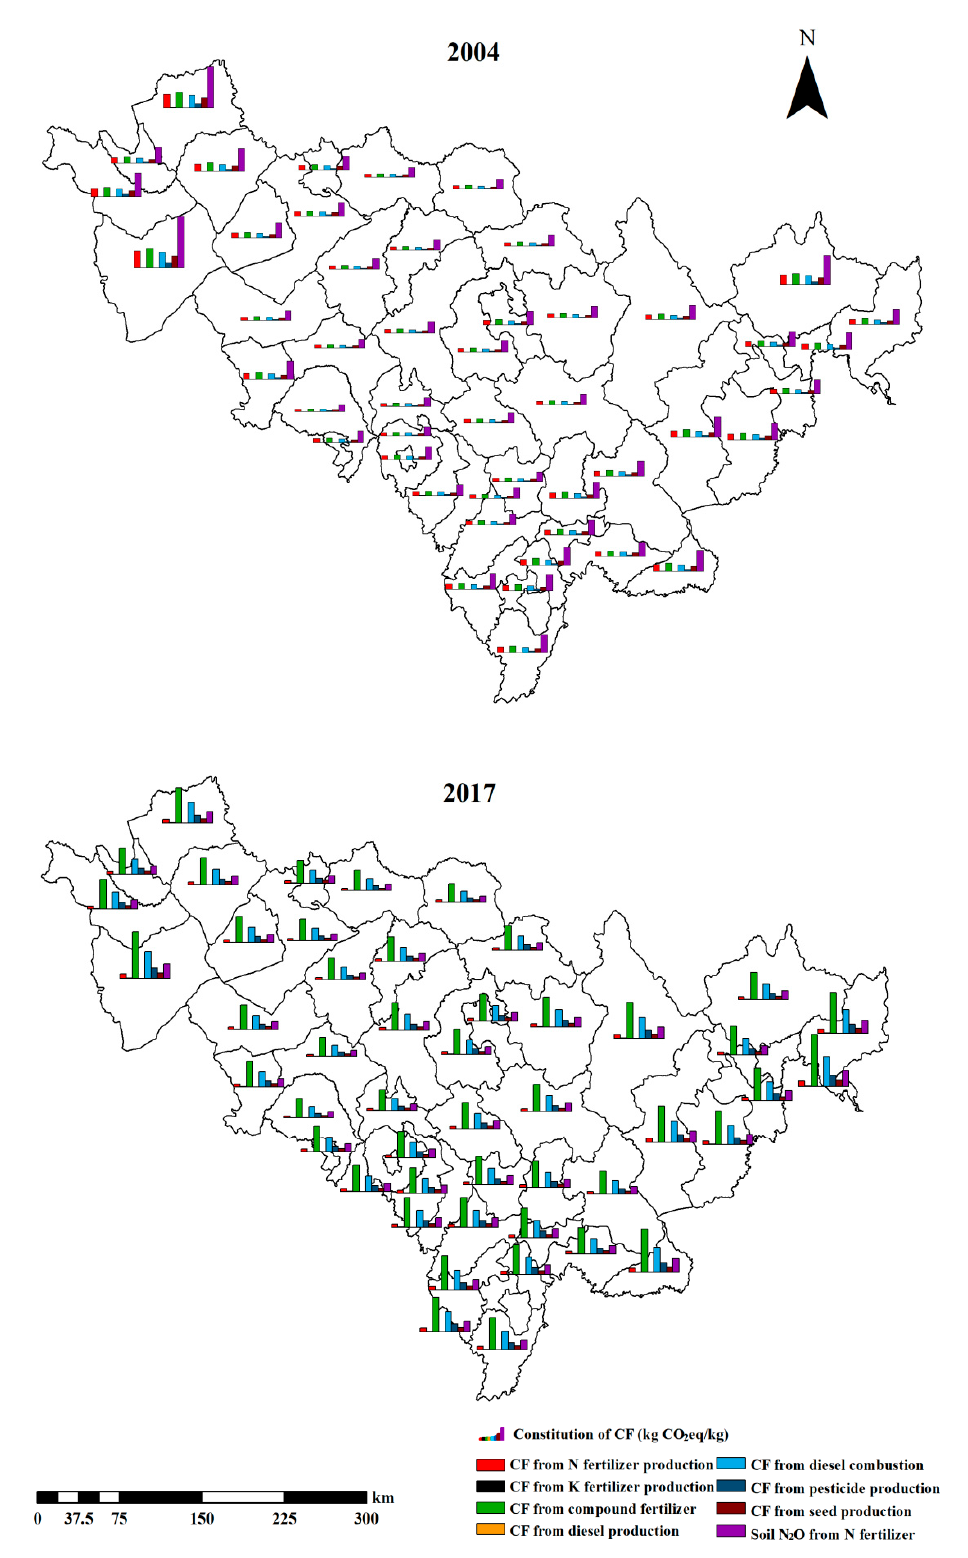
Figure 5. Constitutions of the CFs of maize production in Jilin Province in 2004 and